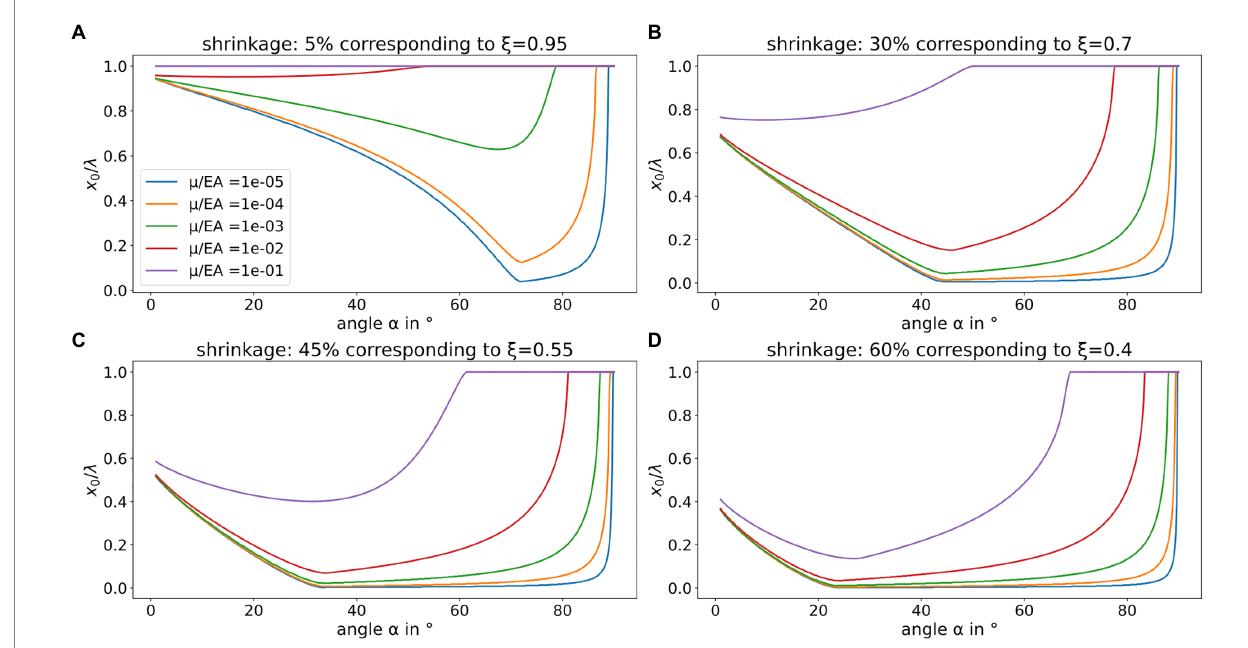
FIGURE 4 Adhesive contact in dependence on shrinkage, surface geometry, adhesive interaction, and fiber stiffness under consideration of a mean effective angle α eff , as the fiber is not necessarily orthogonal to the surface geometry. A ratio x 0 / λ = 1 means full adhesive contact of the fiber and the surface geometry given, whereas x 0 / λ = 0 means that the fiber only touches the tips of the triangular surface geometry. The individual panels show the behavior for different values of shrinkage: (A) 15% shrinkage, (B) 30% shrinkage, (C) 45% shrinkage, and (D) 60% shrinkage. The ratio μ /EA ranging from 10 −5 to 10 −1 is identically color-coded in every panel. To be physically meaningful, the ratio x 0 / λ has to be clipped between 0 and